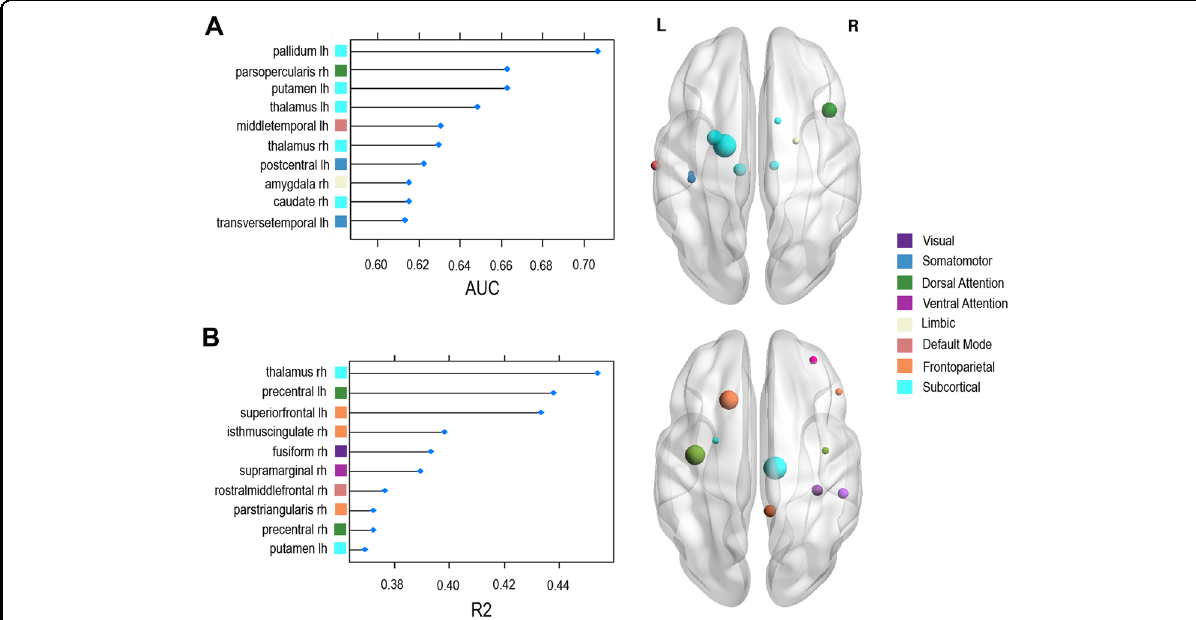
Fig. 1 Ranked variable importance for linear SVM models. A . Regions contributing most to prediction of diagnostic group (ADHD vs TDC). B . Regions contributing most to prediction of change in ADHD symptom severity after 6 weeks of MPH treatment. Representation of location, network and weighting of these regional contributors is shown on the right. For visual clarity, only the top ten most important contributors to the models are shown. Weightings for the remaining contributing brain regions can be found in Supplementary Table